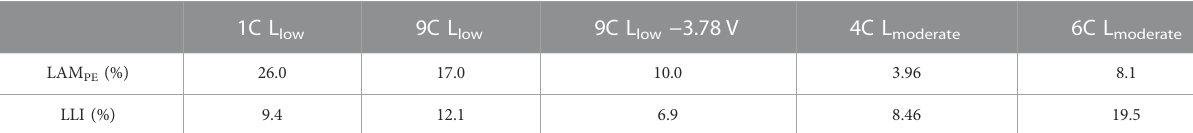
TABLE 1 Percentage of LAM PE and LLI of the cells in Figure 4 obtained using IC analysis.